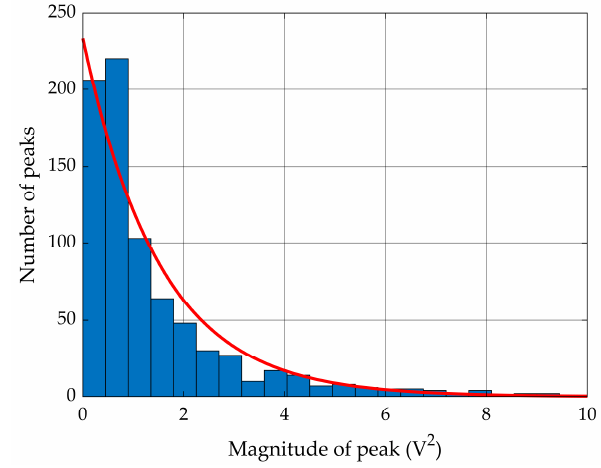
Figure 11. The probability distribution of the magnitude of peaks (blue bars) and the exponential distribution fit (red line) from Transect 3, Pass 6.